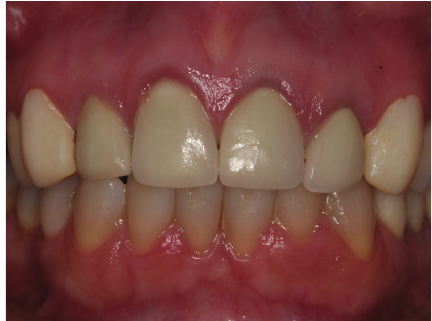
Figure5:Definitiveimpression,close-upviewofpreparationsfinish line.